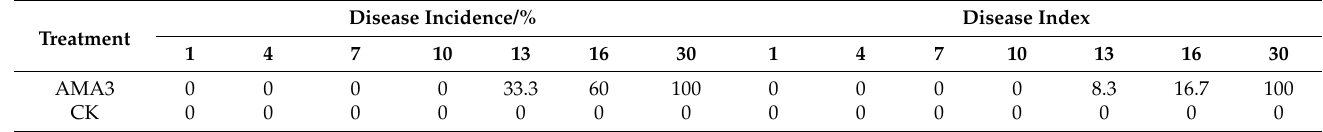
Table 1. Susceptibility and disease index of P. thunbergii seedlings after inoculation with PWN.